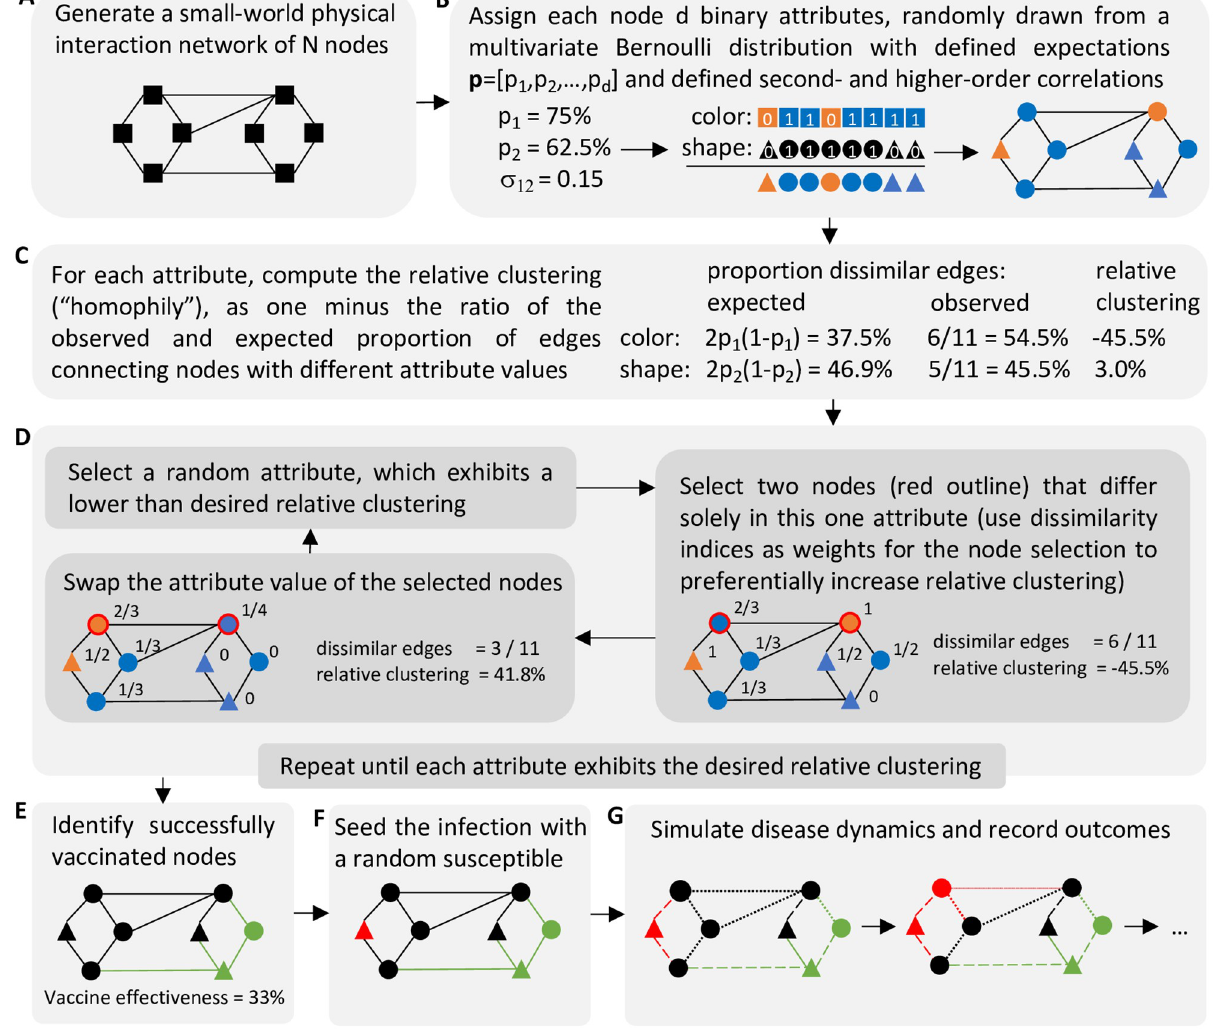
Fig 1. Graphical overview of a simulation run. (A) Generation of a physical interaction network, (B) Assignment of d correlated binary attribute values to each node. If d = 2, the attributes represent e.g. attitude towards vaccines (color) and social distancing (shape), (C) Computation of the relative clustering level (a measure of homophily) of each attribute, (D) Overview of the clustering algorithm used to assign attributes so that the network exhibits a desired level of homophily for each attribute. Values to the right of each node indicate its dissimilarity index: the proportion of neighbors with a different attribute value. (E) Vaccination of all nodes with a positive (blue) attitude towards vaccines and removal of those successfully vaccinated (green) from the pool of susceptible individuals; the probability that an all-or-nothing vaccine awards protection equals its effectiveness, (F) Infection of a randomly selected susceptible node (red), (G) Simulation of the spread of the infection and recording of outcomes. The likelihood of interaction (edge weight) depends on whether nodes practice social distancing (circles) or not (triangles).